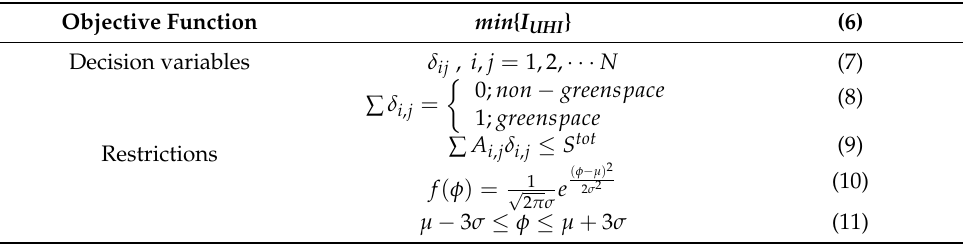
Table 3. Optimization model under the restriction of total green area.